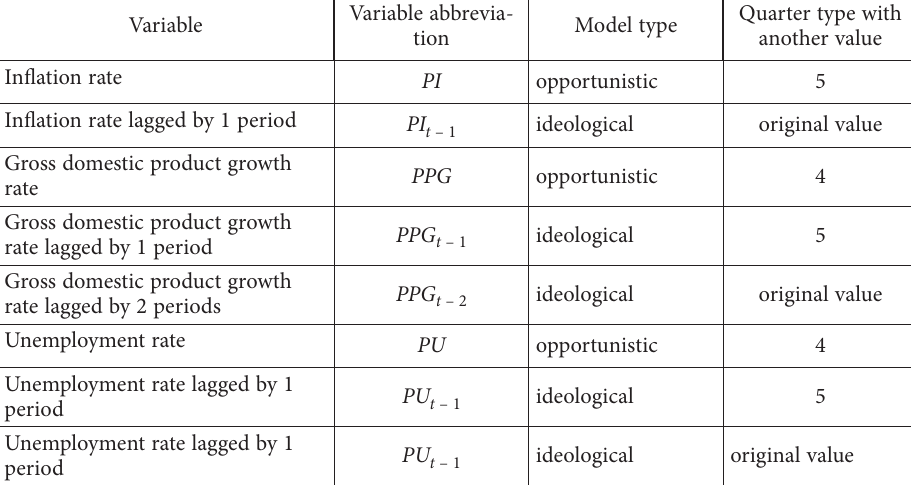
Table 2. Overview of the political dummy variables (source: own elaboration by the